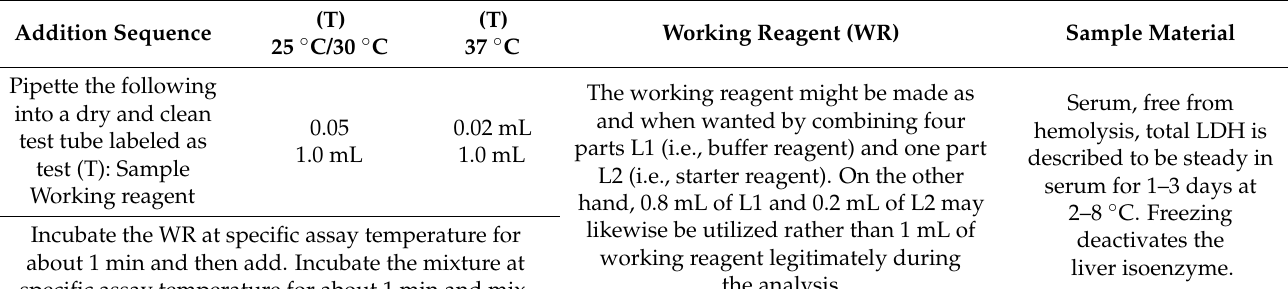
Table 3. Estimation protocol for lactate dehydrogenase